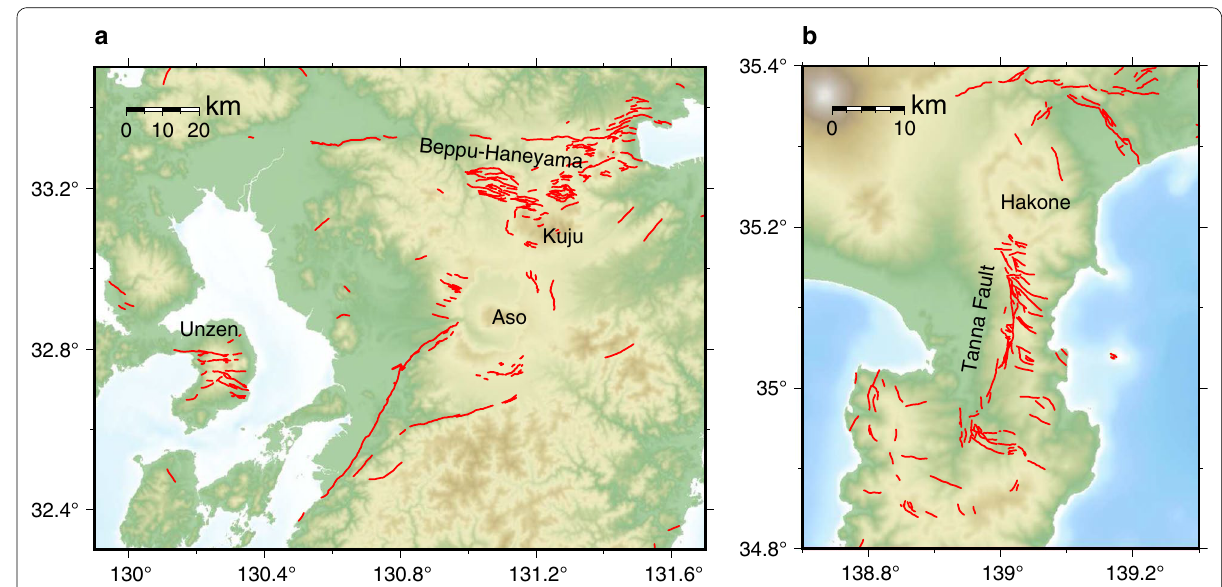
Fig. 11 a Active faults in the central Kyushu, showing the clustered faults around the Unzen volcano and in the Beppu–Haneyama fault zone. b Tanna fault and surrounding active faults. Active fault traces include presumed ones and are from Nakata and Imaizumi (2002)